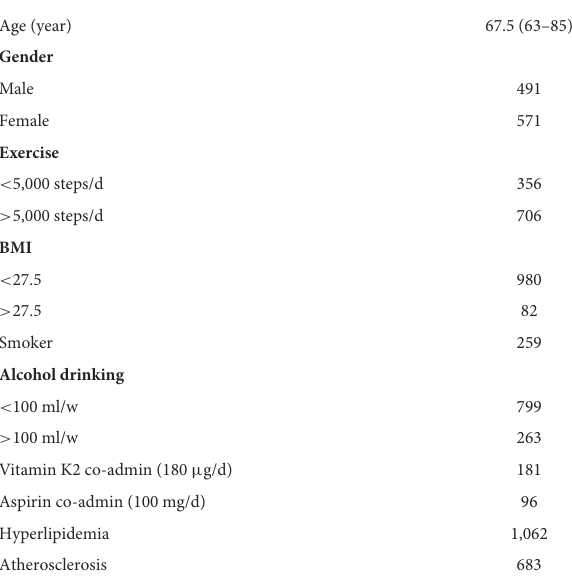
TABLE 1 Baseline characteristics of the participants.